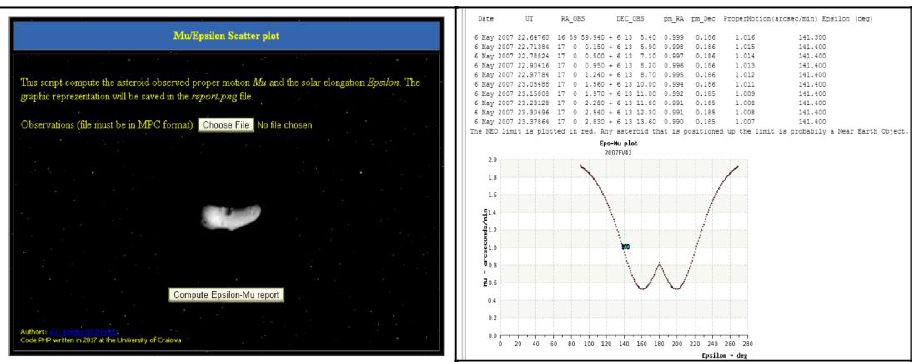
Fig. 4. The Mu-Eps Scatter